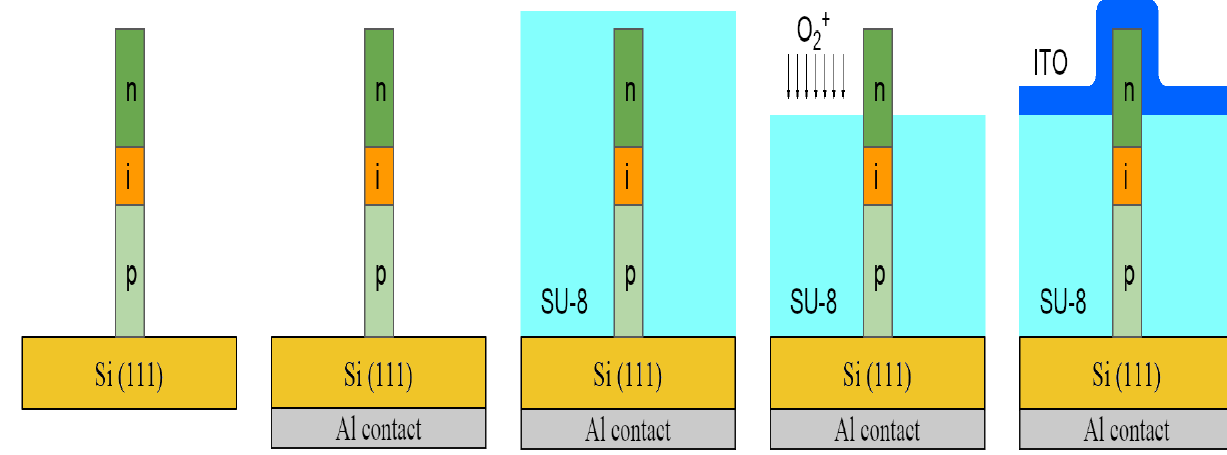
Figure 3. Workflow schematic for NW LED-on-Si.